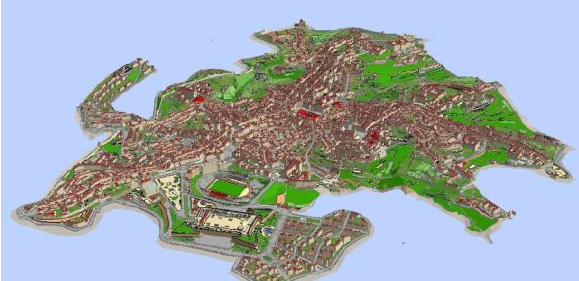
Figure 1 - TDB of medieval Siena.